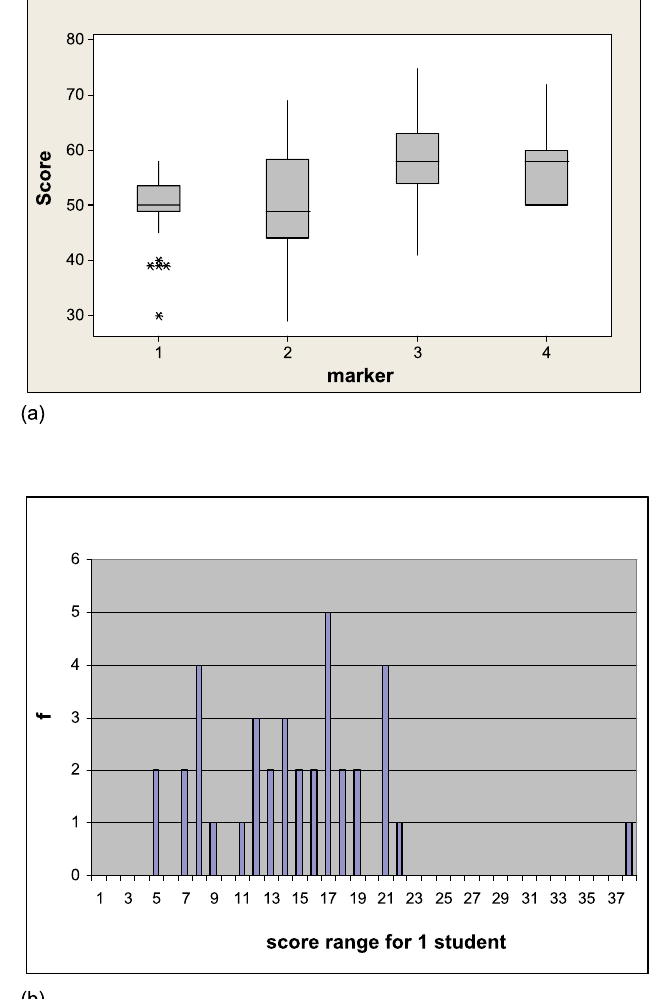
Figure 2. (a) Boxplot of score by marker alone. (b) Variation in scores between